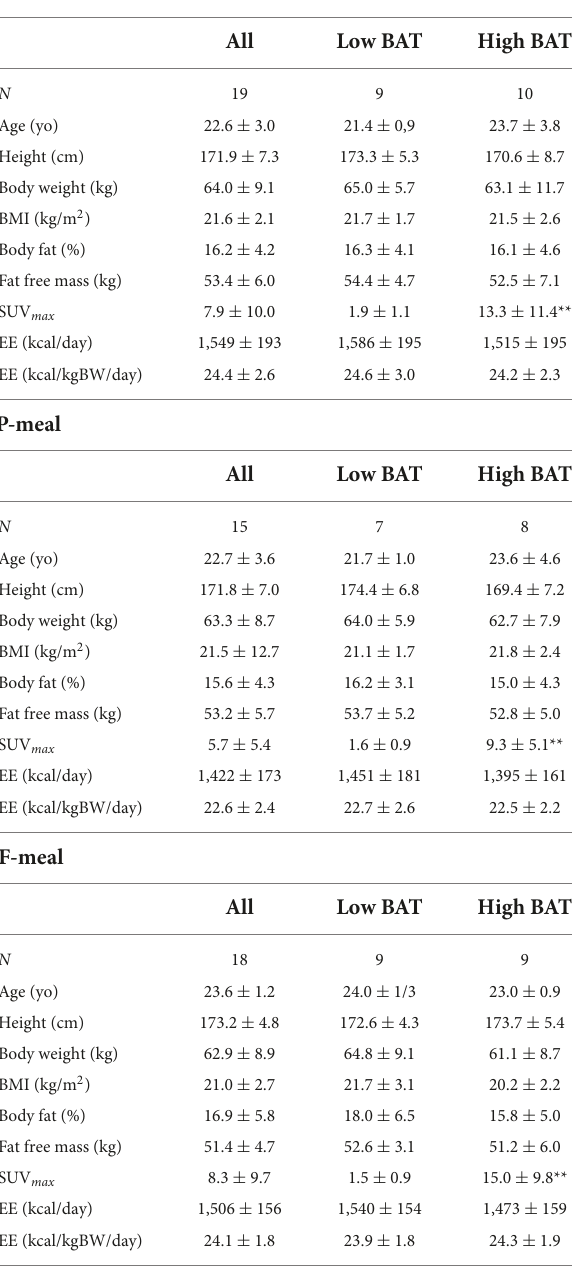
TABLE 2 Participant